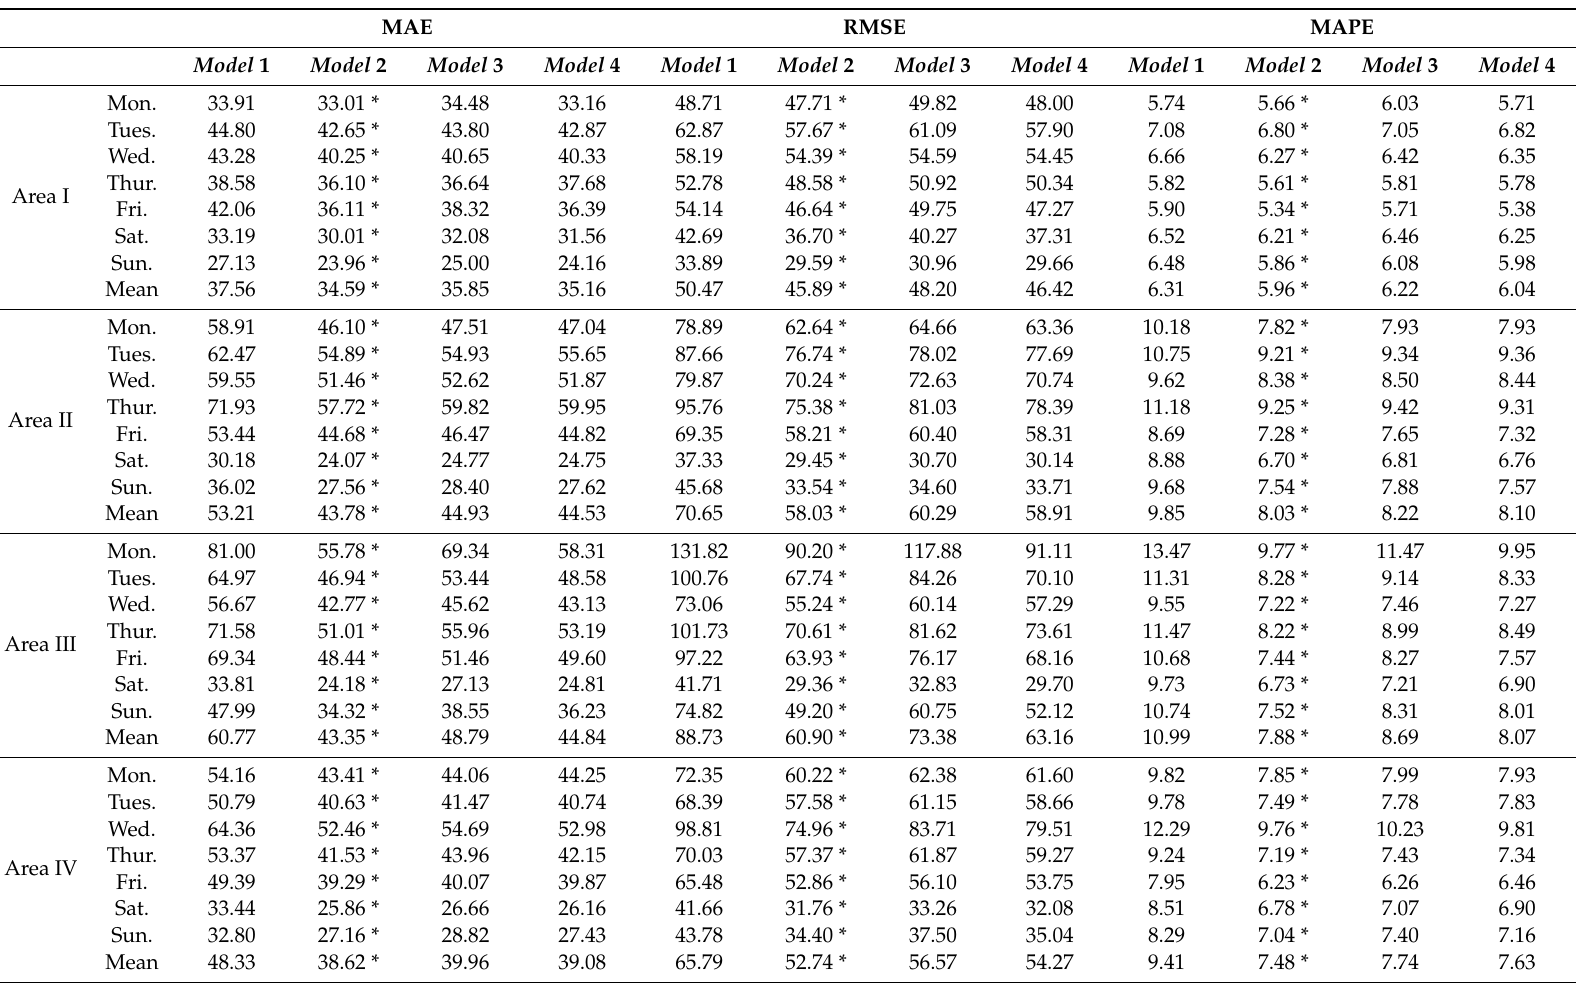
Table 4. Average mean absolute error (MAE), root mean square error (RMSE), and mean absolute percentage (MAPE) values of paths in Areas I–IV from Monday to Sunday of the four assimilation